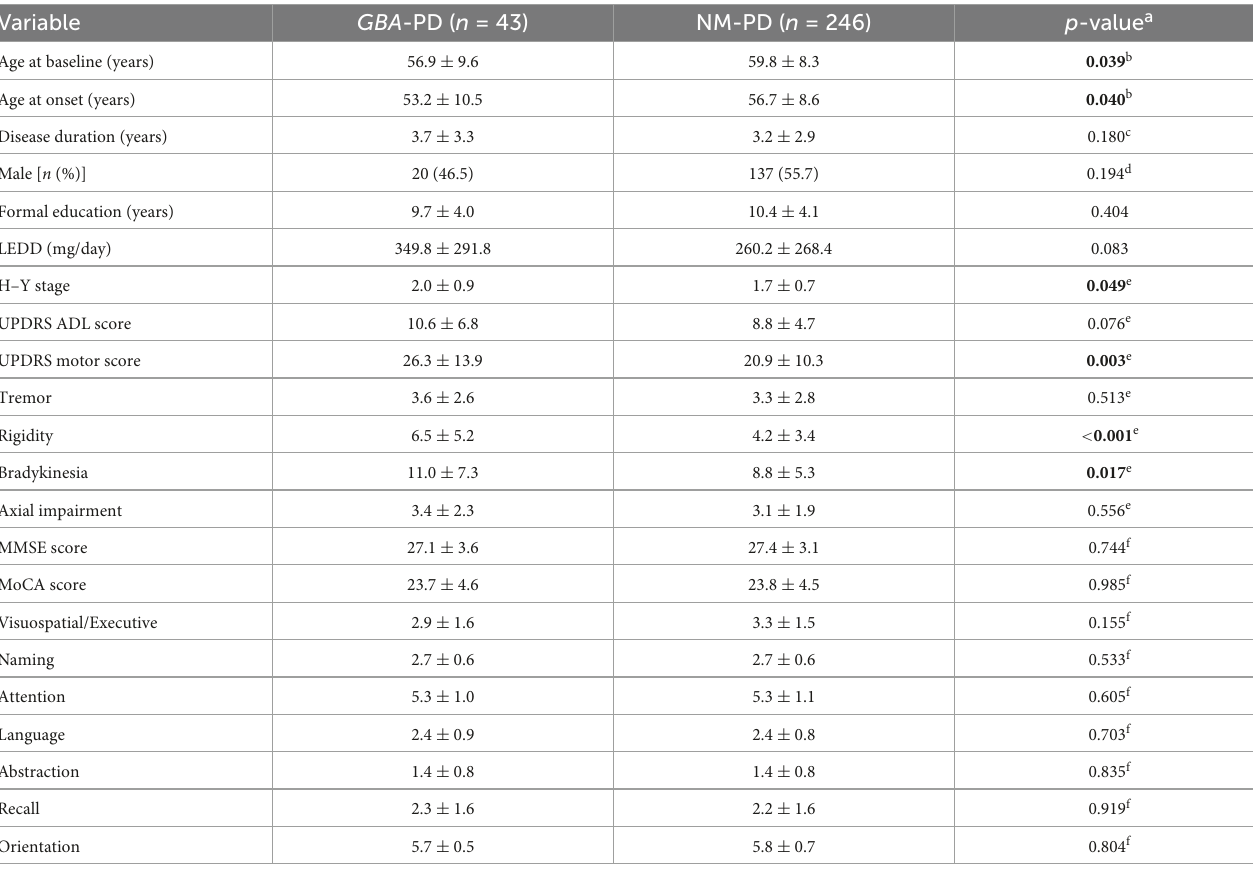
TABLE 1 Baseline demographic and clinical features of GBA -related PD ( GBA -PD) and non- GBA mutated PD (NM-PD) patients. Variable